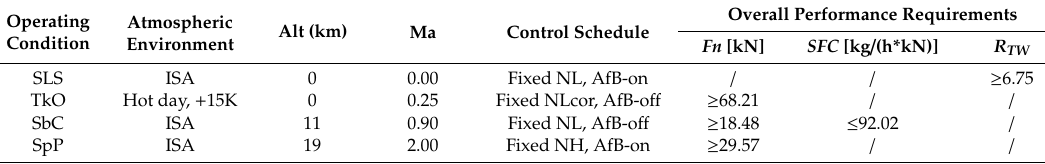
Table 3. Overall performance requirements in flight profile.